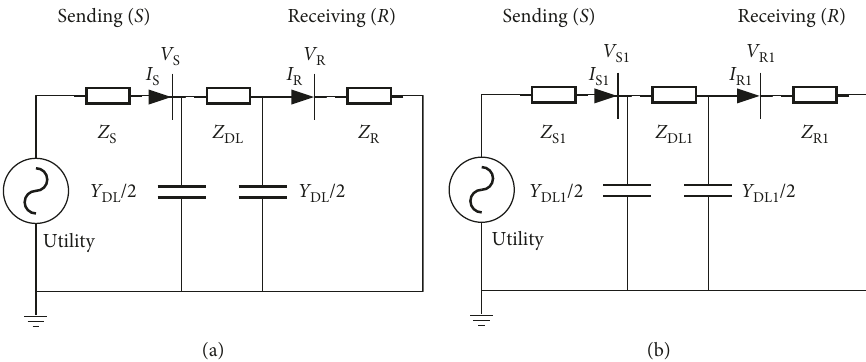
Figure 1: Distribution line equivalent model ( π -Type). (a) One-line diagram using the phasor quantities (b) One-line diagram using the